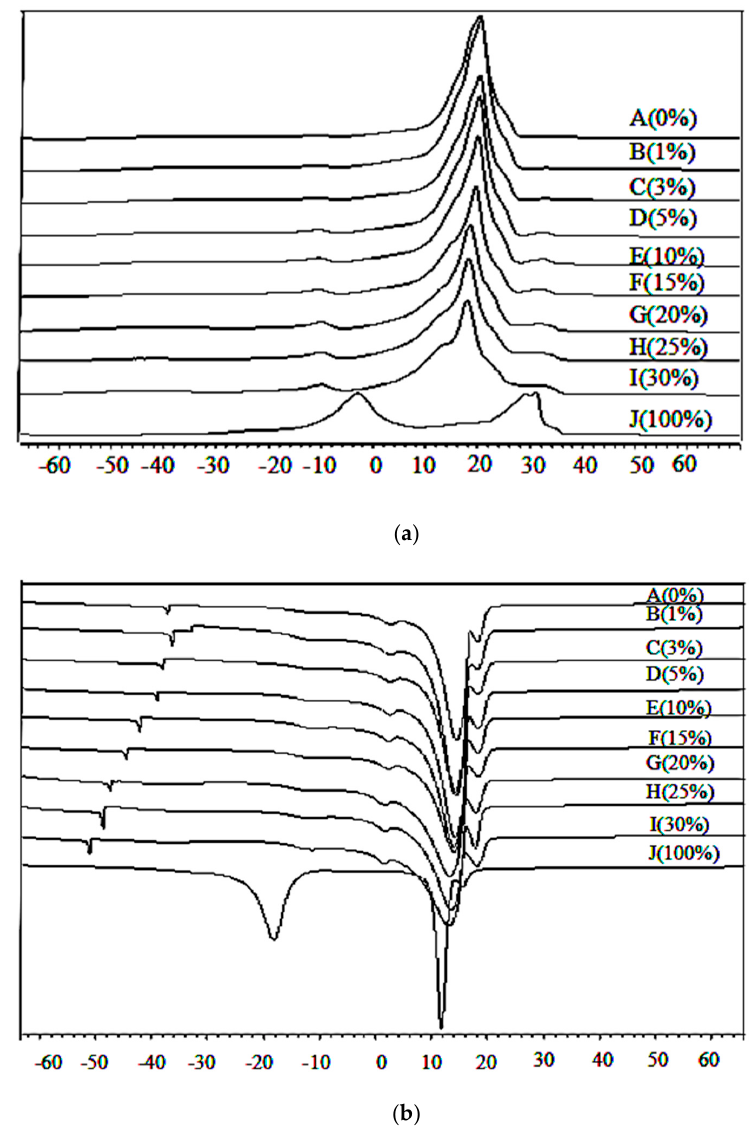
Figure 2. Differential scanning calorimetry ( a ) heating and ( b ) cooling thermogram of lard (LD; J: 100%), cocoa butter (CB; A: 0%), and their admixtures.